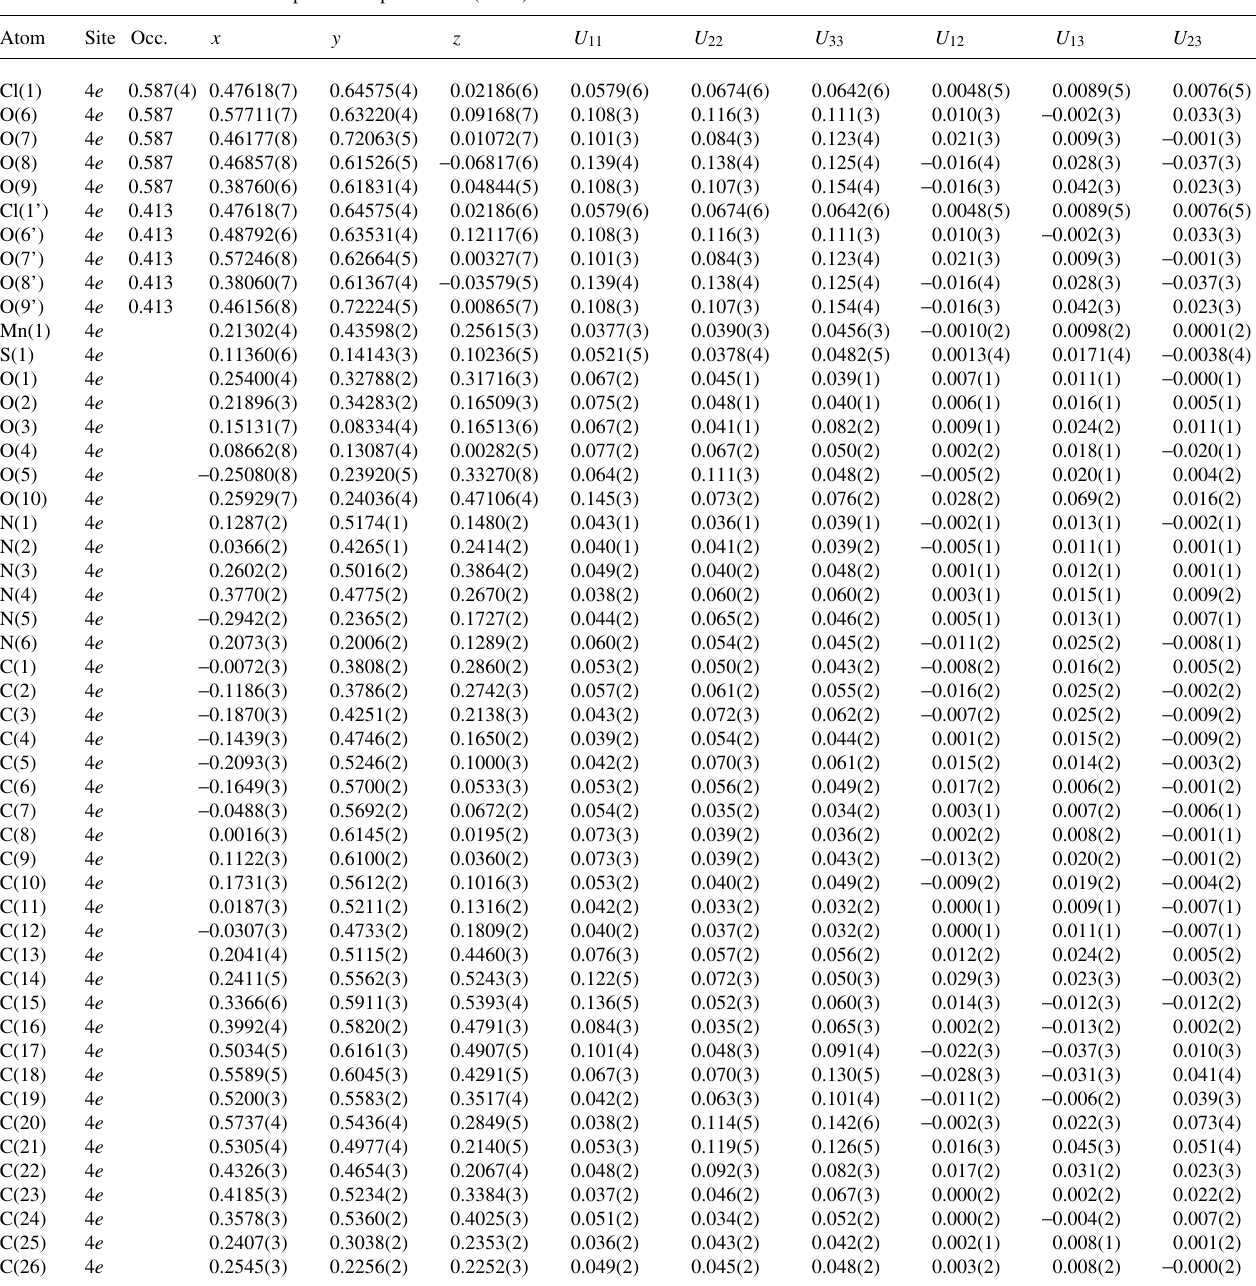
Table 3. Atomic coordinates and displacement parameters (in Å 2 )